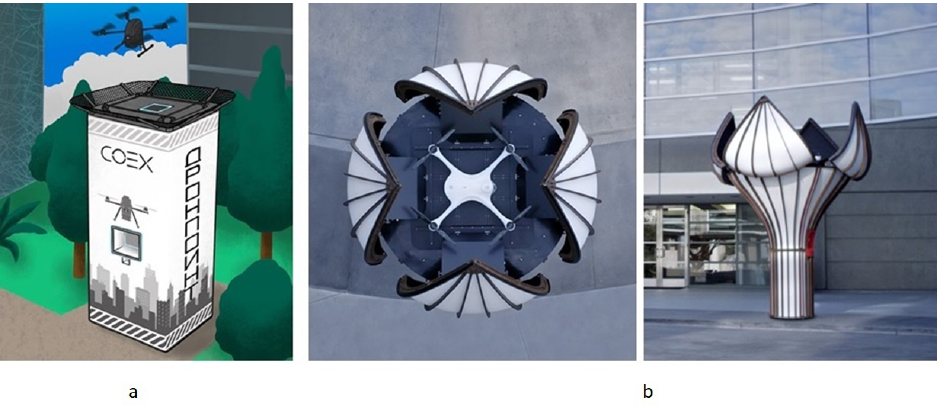
Figure 12. Examples of commercially available platforms for UAVs with parallel pushers with cargo unloading by: ( a ), COEX [47]; and ( b ), Matternet [49].